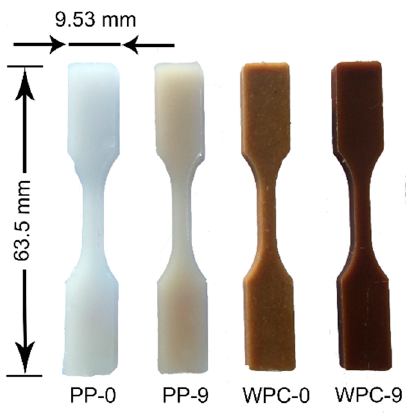
Figure 6. A color change in the PP and WPCs samples from the start through to nine recycling passes.